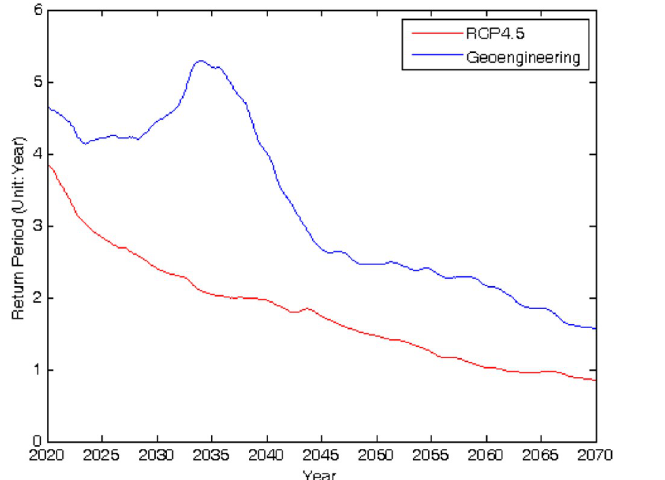
Projected return period of Category